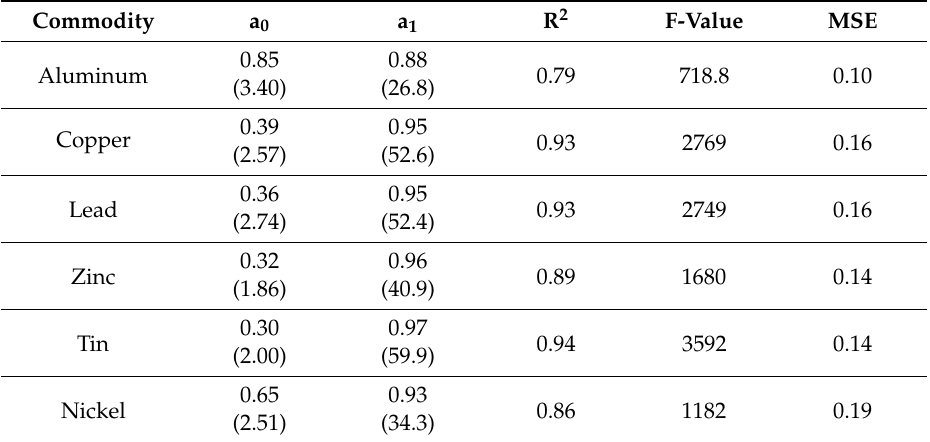
Table 4. OLS parameter estimates of Equation (1): monthly data analysis.